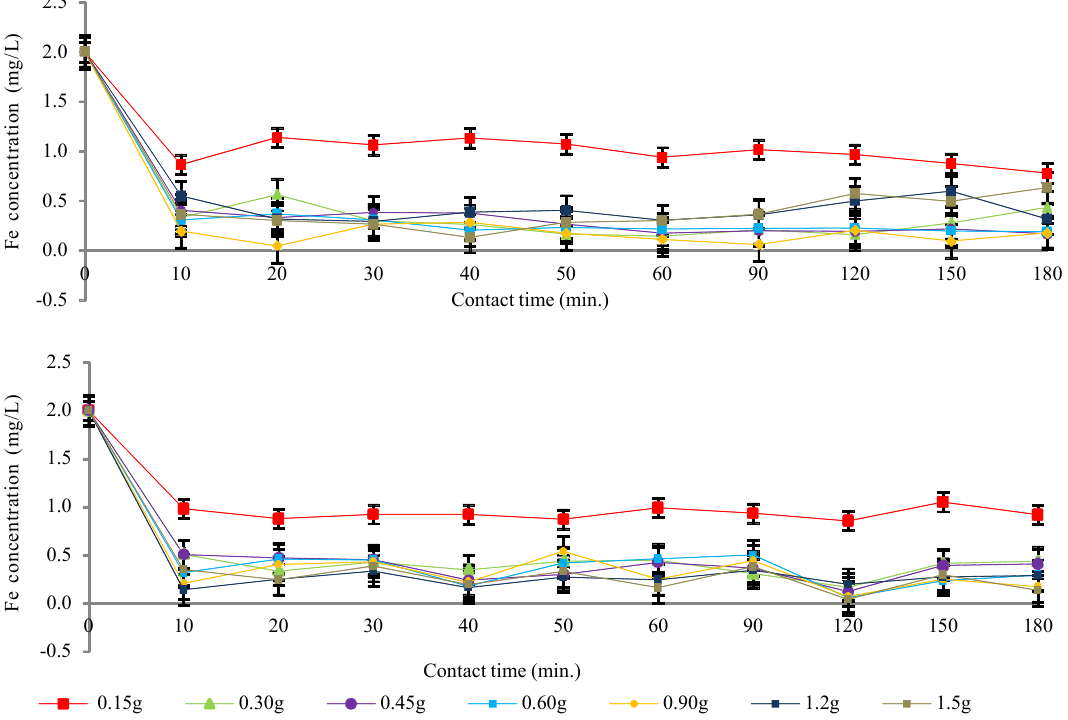
Fig. 2: Iron (II) removal for several dosages (a) CCE (b)